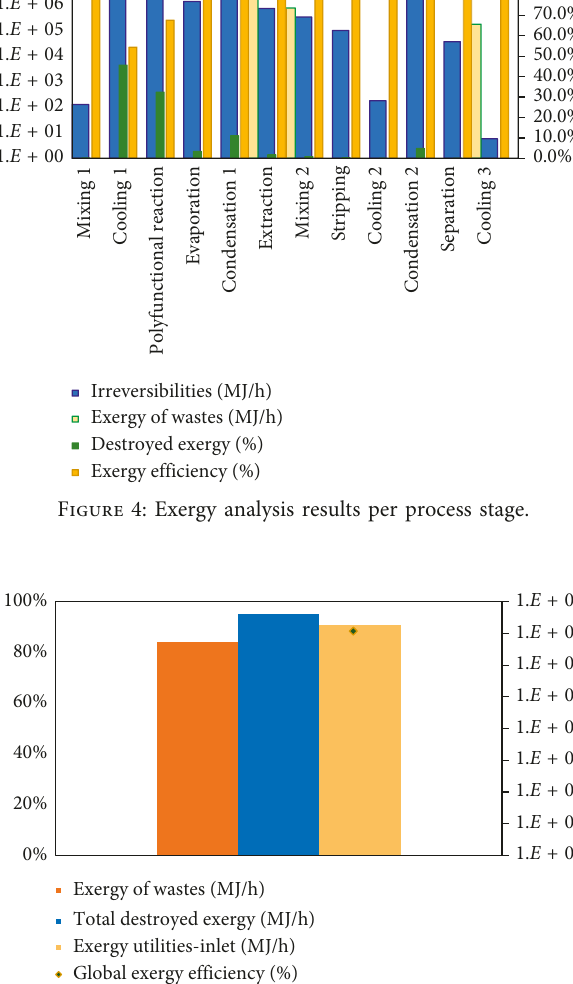
Figure 5: Global exergy analysis results for nitrobenzene production.